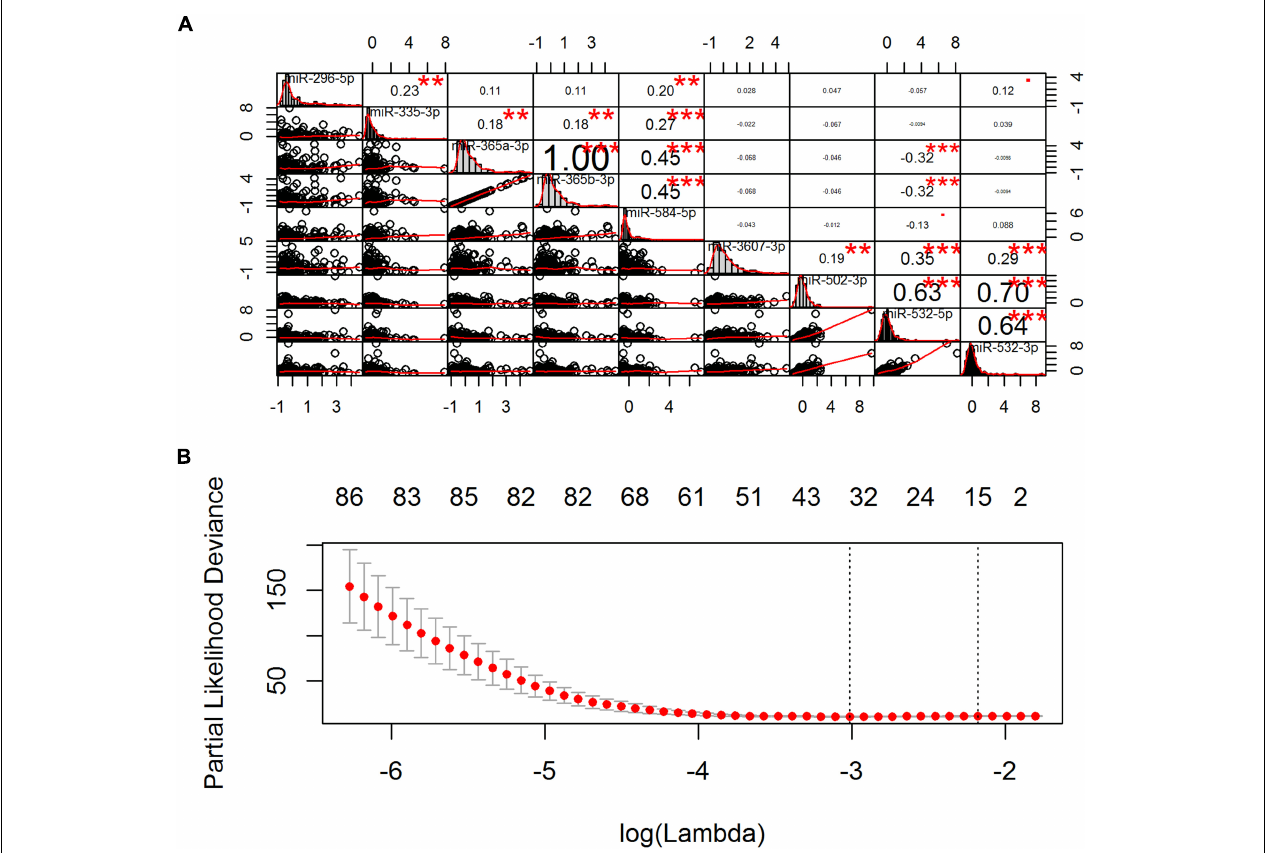
FIGURE 2 | Pairwise correlation and cross-validation. (A) The diagonal, upper triangular, and lower triangular of the correlation plot is the histogram, scatter plot, and correlation coefficient and significance, respectively. ∗ P < 0.05, ∗∗ P < 0.01, ∗∗∗ P < 0.001. (B) The left vertical line shows where the cross-validation error curve hits its minimum, the right vertical line shows the most regularized model with cross-validation error within 1 standard deviation of the minimum, and the numbers at the top of the Figure indicate the number of the nonzero coefficients. The optimal model is chosen where the cross-validation error curve hits its minimum (left vertical